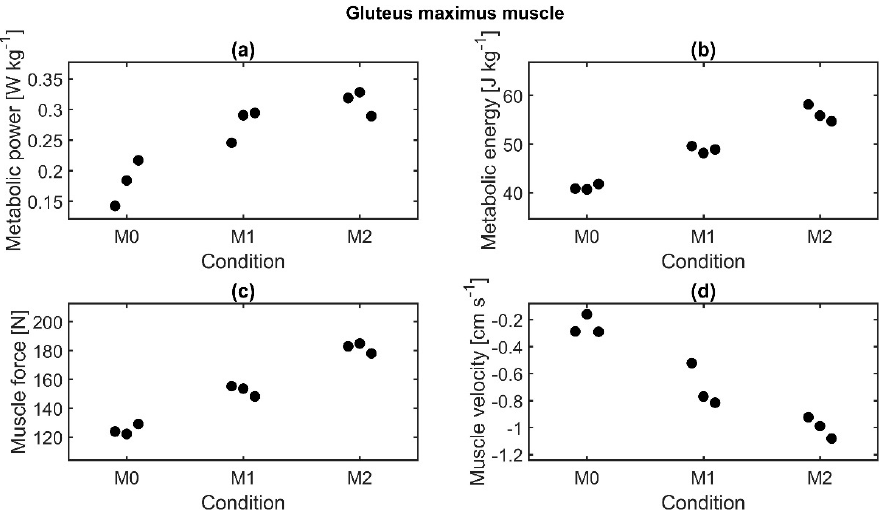
Figure 9. Muscle parameters of the gluteus maximus muscle of subject 8 for three repetitions per condition. Median values are displayed. ( a ) Metabolic power normalized to body weight, ( b ) metabolic energy normalized to body weight, ( c ) muscle force, and ( d ) muscle velocity. For all four parameters of the vastus lateralis muscle, an increase with additional loads could be seen (Figure 10). Only metabolic energy and muscle force were found to be significantly affected by the load based on ANOVA test results, but again, post hoc tests did not reveal any significant difference between the conditions.